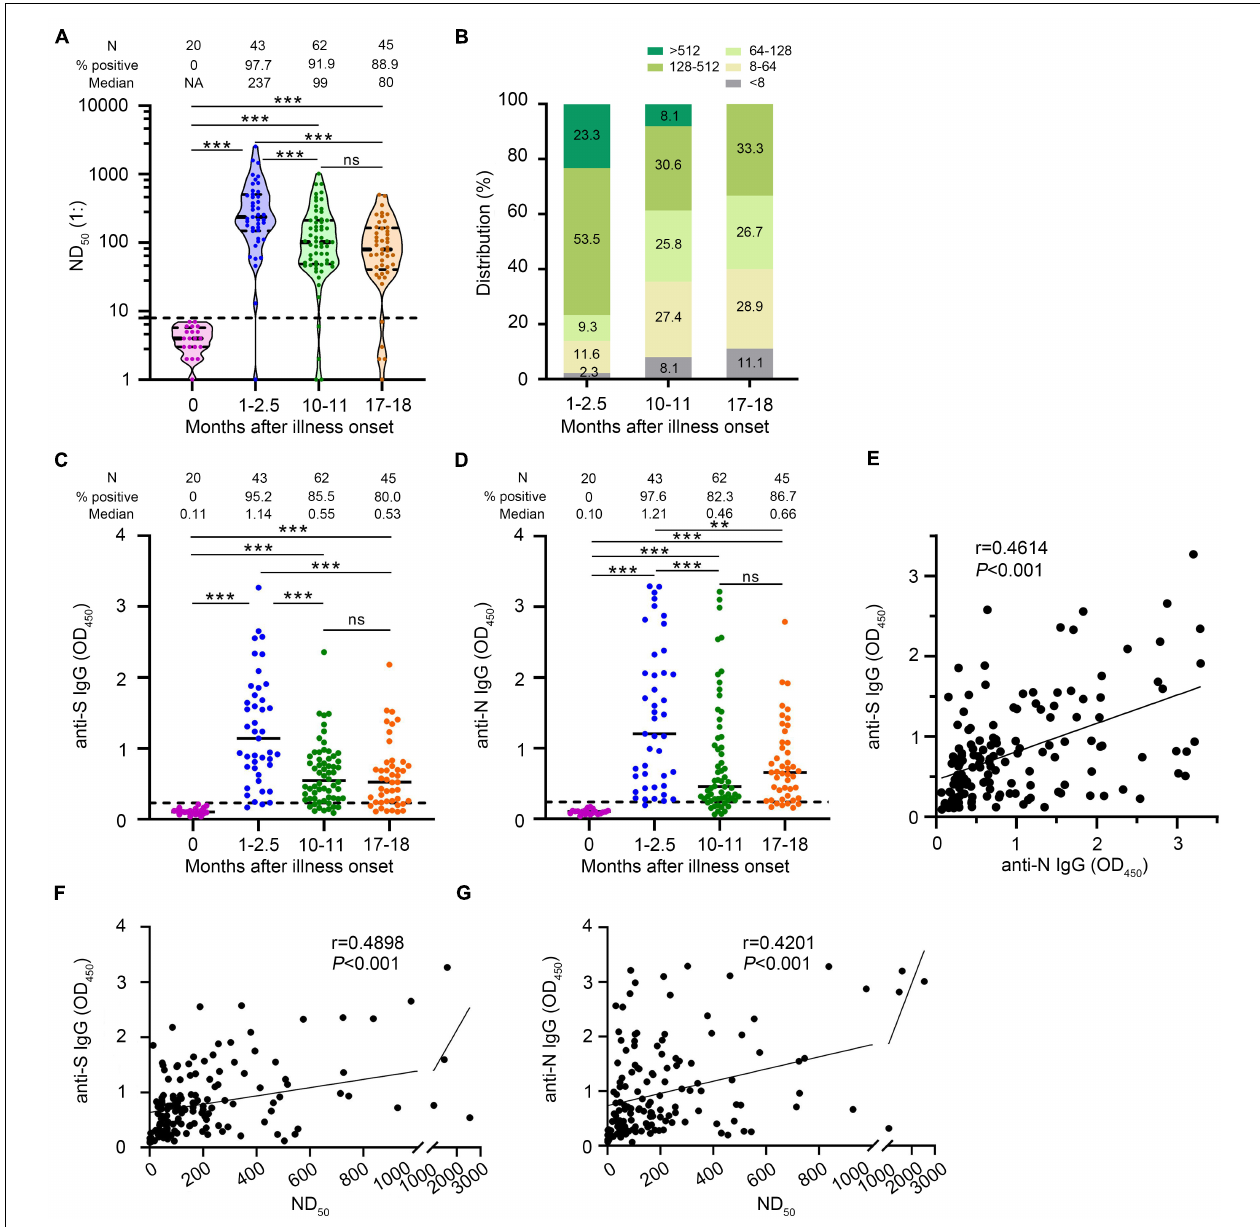
FIGURE 3 | Changes in antibody levels against SARS-CoV-2 after illness onset. (A) Neutralizing antibody titers (ND 50 ) of COVID-19 patients’ serum sample. (B) Distribution of the neutralizing antibody titer in serum samples from COVID-19 patients. (C) SARS-CoV-2 spike (S) IgG antibody levels. (D) SARS-CoV-2 nucleocapsid (N) IgG antibody levels. (E) Correlation of anti-S IgG levels and anti-N IgG levels ( N = 150). (F) Correlation of ND 50 and anti-S IgG levels ( N = 150). (G) Correlation of ND 50 and anti-N IgG levels ( N = 150). Statistical significance of antibody levels was determined using the Mann–Whitney U -test. A two-sided Spearman rank correlation test was used to evaluate the correlation of the levels of different antibodies. Healthy persons were indicated as 0 month after illness onset. Each dot represents an individual patient. Bars represent the median and interquartile range (IQR). The dotted line represents the threshold for positive in this assay. All serum samples were tested at least in duplicate. N, number; NA, not available; ns, not significant; ** p < 0.01, *** p <